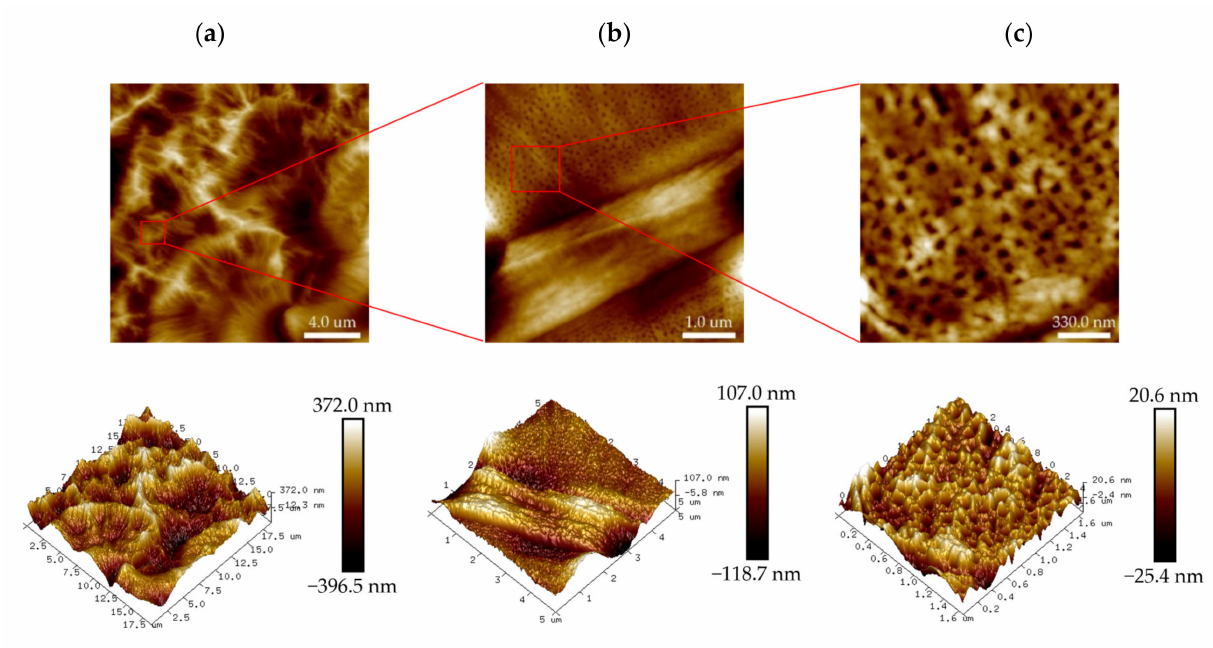
Figure 14. Two-dimensional (2D) and three-dimensional (3D) images of the PHRO gel in 20.0 wt% NaCl solution with AFM. ( a ) Scanning area is 18.8 µ m × 18.8 µ m; ( b ) scanning area is 5.0 µ m × 5.0 µ m; ( c ) scanning area is 1.7 µ m × 1.7 µ